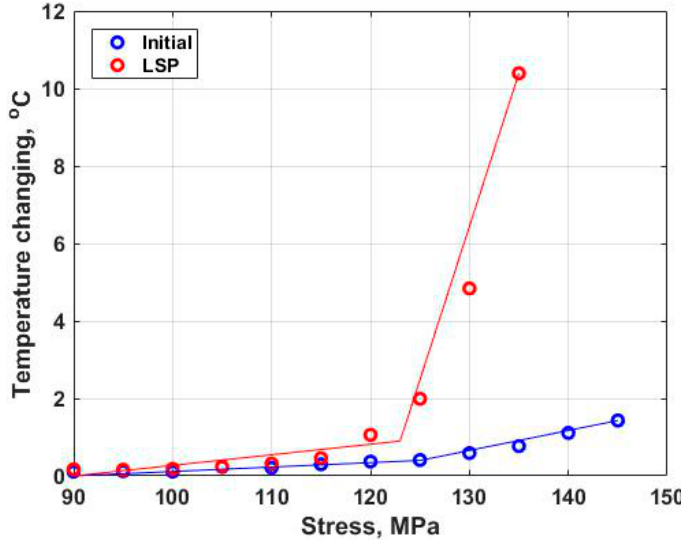
Figure 3. Surface temperature evolution vs. applied stress amplitude for the fatigue specimen without LSP treatment (initial), and the fatigue specimen with LSP treatment.